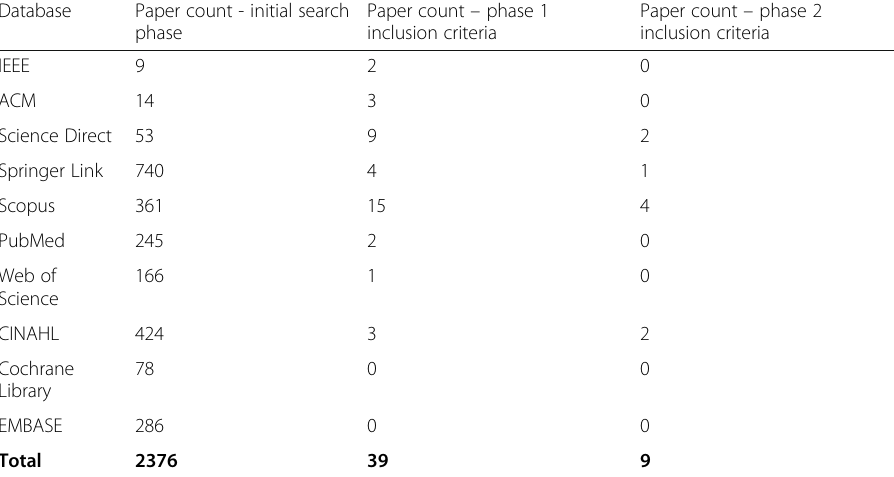
Table 1 Result-set size for each database for each search phase Database Paper count - initial search